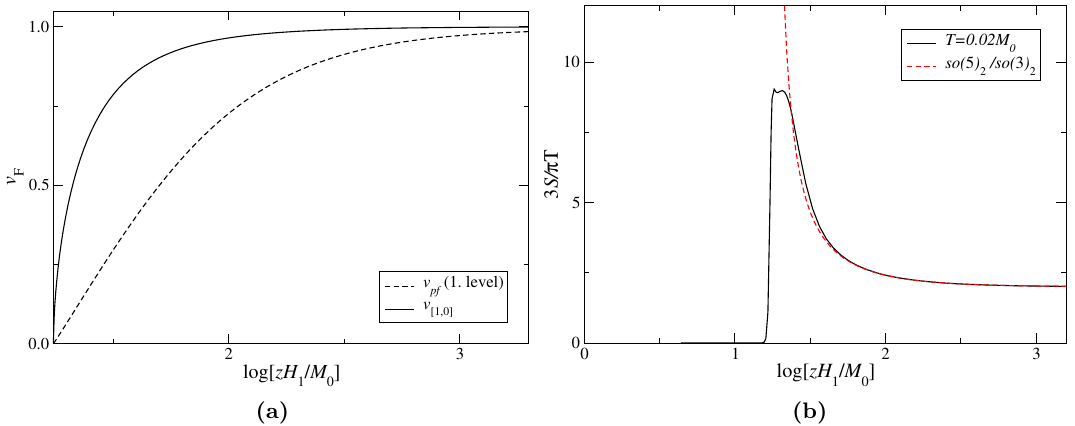
Figure 4 . (a) Fermi velocities of the [1 ; 0]-solitons and (cid:12)rst level parafermion modes as a function of the (cid:12)eld zH 1 =M 0 for p 0 = 2 + 1 = 3, H 2 (cid:17) 0 at zero temperature. For large (cid:12)eld, H 1 > H 1 ;(cid:14) , both Fermi velocities approach 1 leading to the asymptotic result for the low-temperature entropy (2.26). (b) Entropy obtained from numerical solution of the TBA equations (2.12) for p 0 = 2 + 1 = 3 and H 2 (cid:17) 0 as a function of the (cid:12)eld zH 1 =M 0 for T = 0 : 02 M 0 . For (cid:12)elds large compared to the p [1 ; 0]-soliton mass, zH 1 (cid:29) 2 3 M 0 , the entropy approaches the expected analytical value (2.26) for a (cid:12)eld theory with a free bosonic sector and a Z =Z parafermion sector SO(5) Nf SO(3) Nf